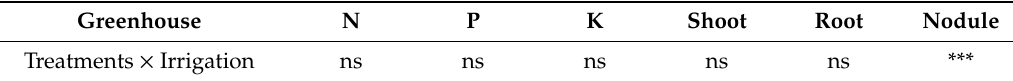
Table 2. Interaction e ff ects of treatments (Control, HISTICK, BHTC), and irrigation (Watered, Drought) on the plant N, P, K content, shoot and root biomass, and nodule number. Significance denoted by *** p <